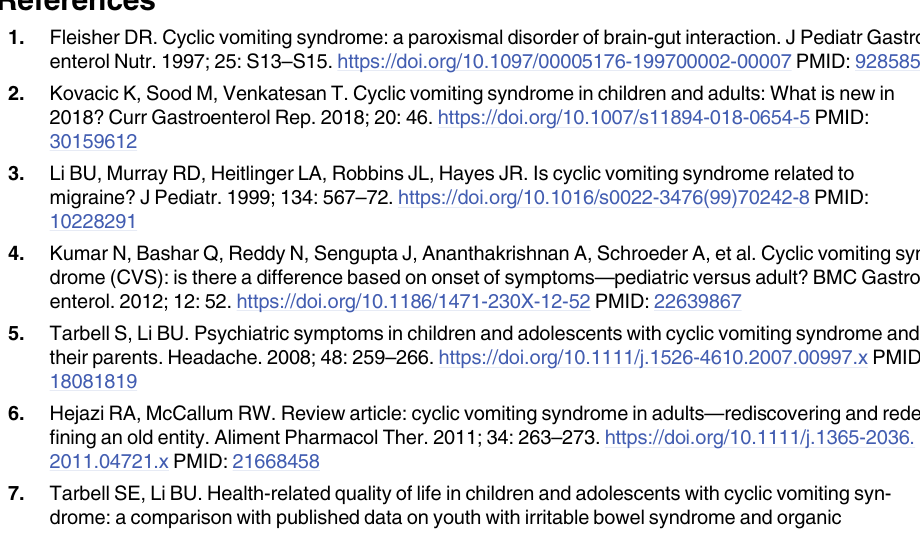
S1 Table. Definitions of medical conditions associated with